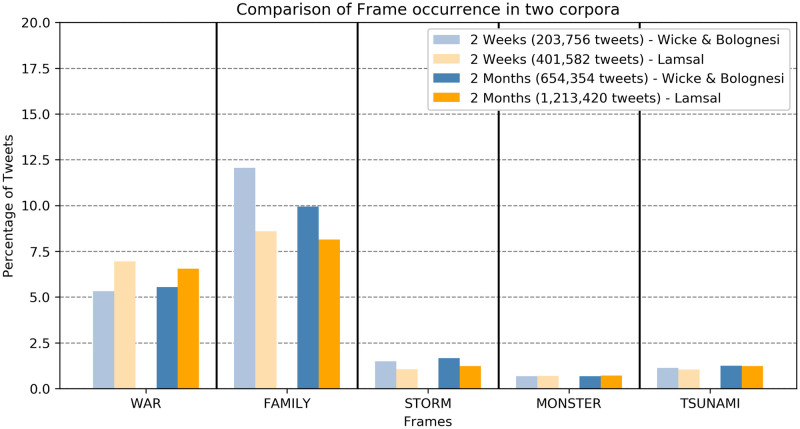
Comparison of the two corpora for five frames and two time spans (2 weeks, 2 months).Each bar indicates the percentage of a frame within the respective corpus.